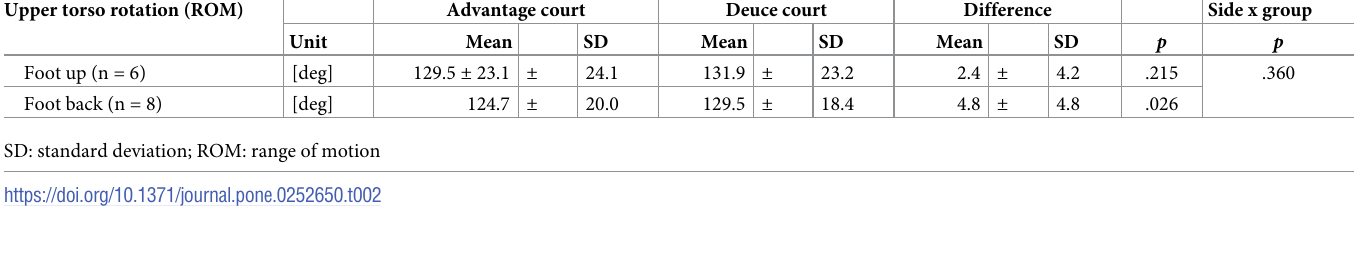
Table 2. Upper torso ROM in foot-up and foot-back players. Upper torso rotation (ROM) Advantage court Deuce court Difference Side x